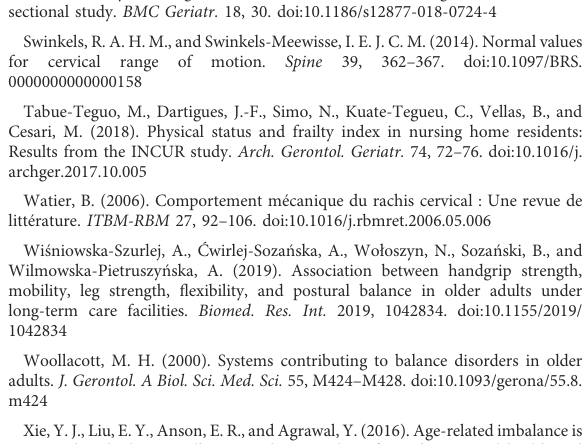
Tabue-Teguo, M., Dartigues, J.-F., Simo, N., Kuate-Tegueu, C., Vellas, B., and Cesari, M. (2018). Physical status and frailty index in nursing home residents: Results from the INCUR study. Arch. Gerontol. Geriatr. 74, 72 – 76. doi:10.1016/j.